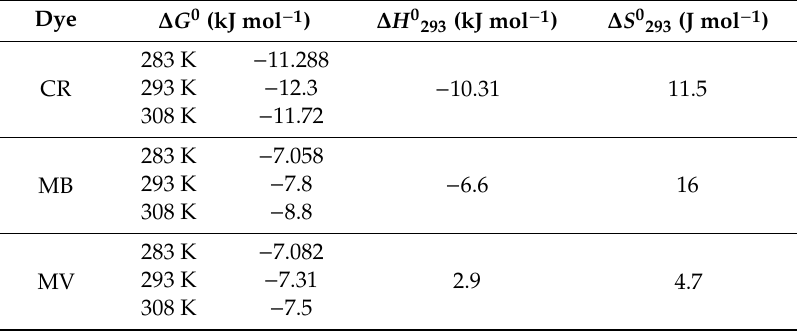
Table 6. Thermodynamic parameters of the adsorption process.